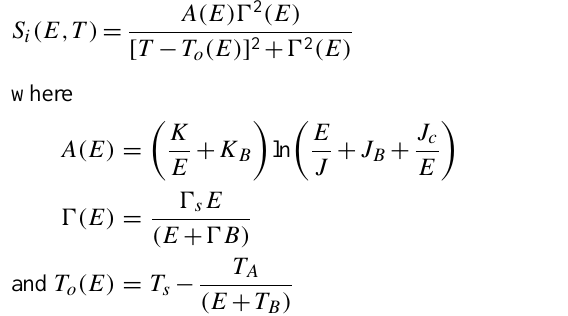
The cross sections for the photoelectron impact ionization reaction is taken from the work of Jackman et al. (1977) which is based on the differential scattering cross section as given by Green and Sawada (1972). The differential cross section is given by the following